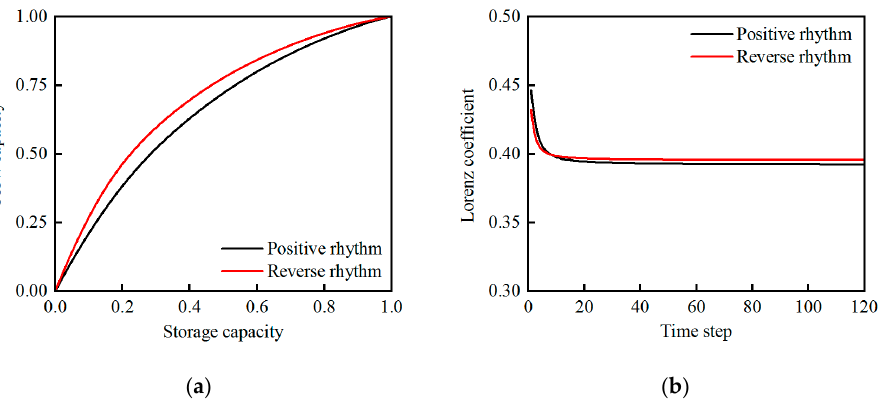
Figure 6. Flow heterogeneity evaluation of synthetic models with different rhythms. ( a ) Lorenz curve; ( b ) flow heterogeneity curve.